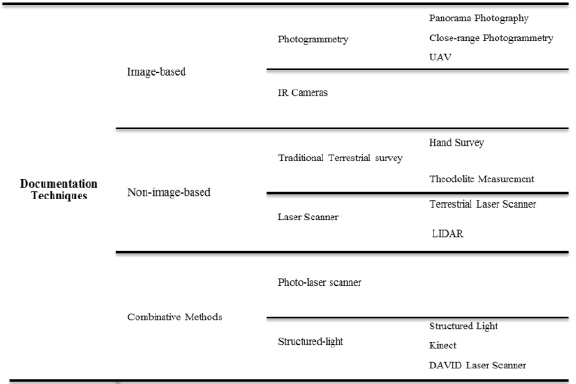
Figure 1. The categorization of documentation